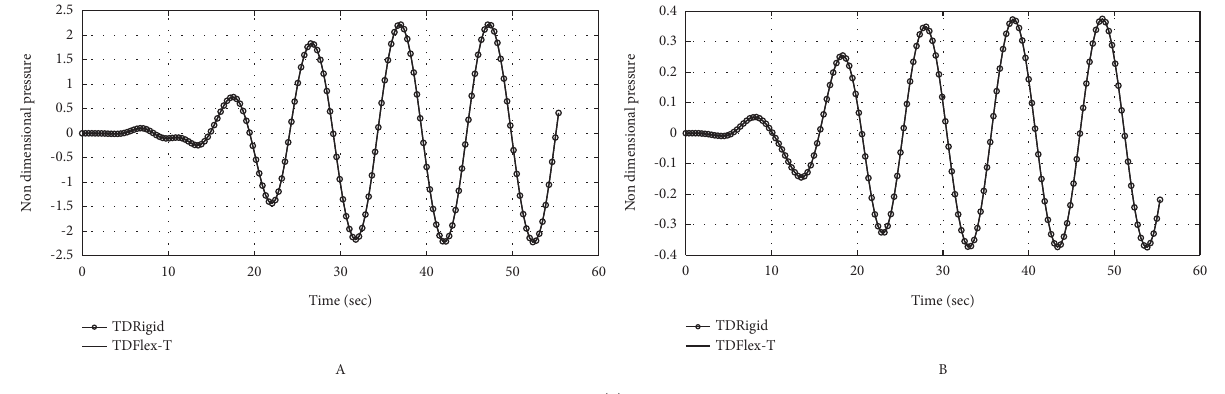
Figure 17: Schematic diagram of selection of panels (squares 1–3 highlight free surface locations; 4–6 highlight ship bottom locations).